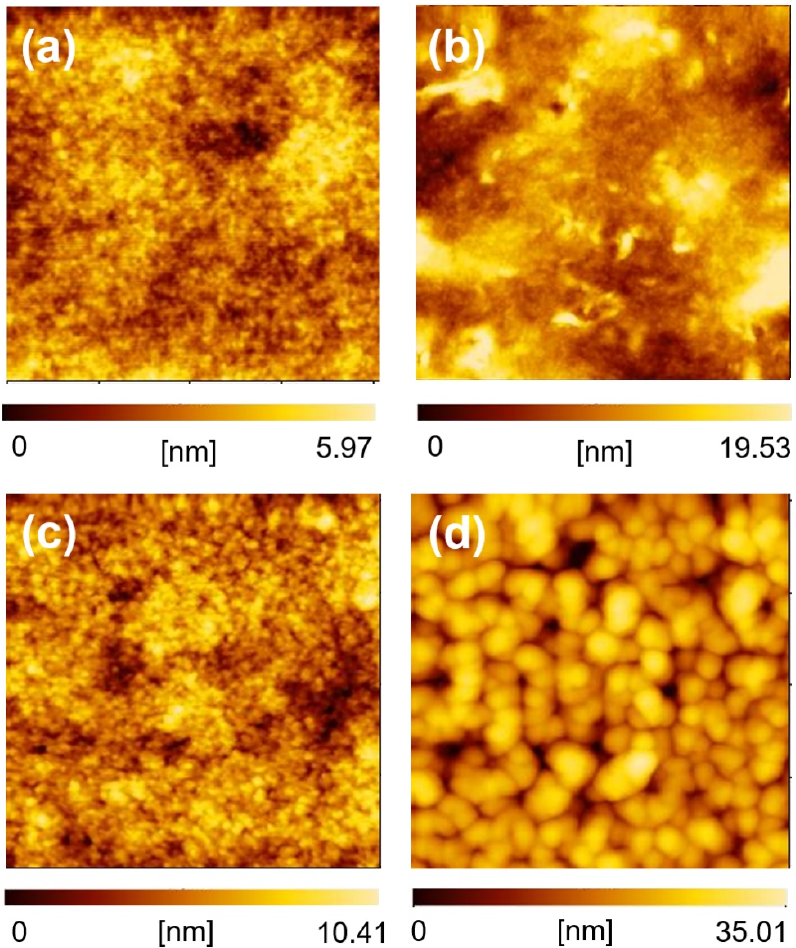
Figure 4. AFM images of blend films (2  m × 2  m) before ( a , b ) and after ( c ), ( d ) BGE washing. PTB7/EH-IDTBR films ( a ), ( c ) and PTB7/ITIC films ( b , d ). PTB7/EH-IDTBR films ( a ), ( c ) and PTB7/ITIC films ( b , d